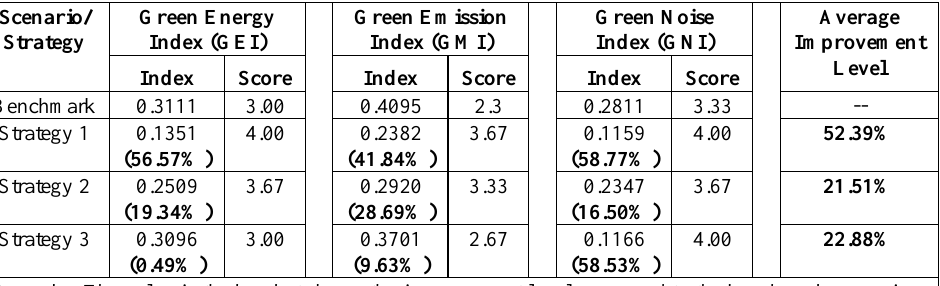
Table 6. The results of green indexes